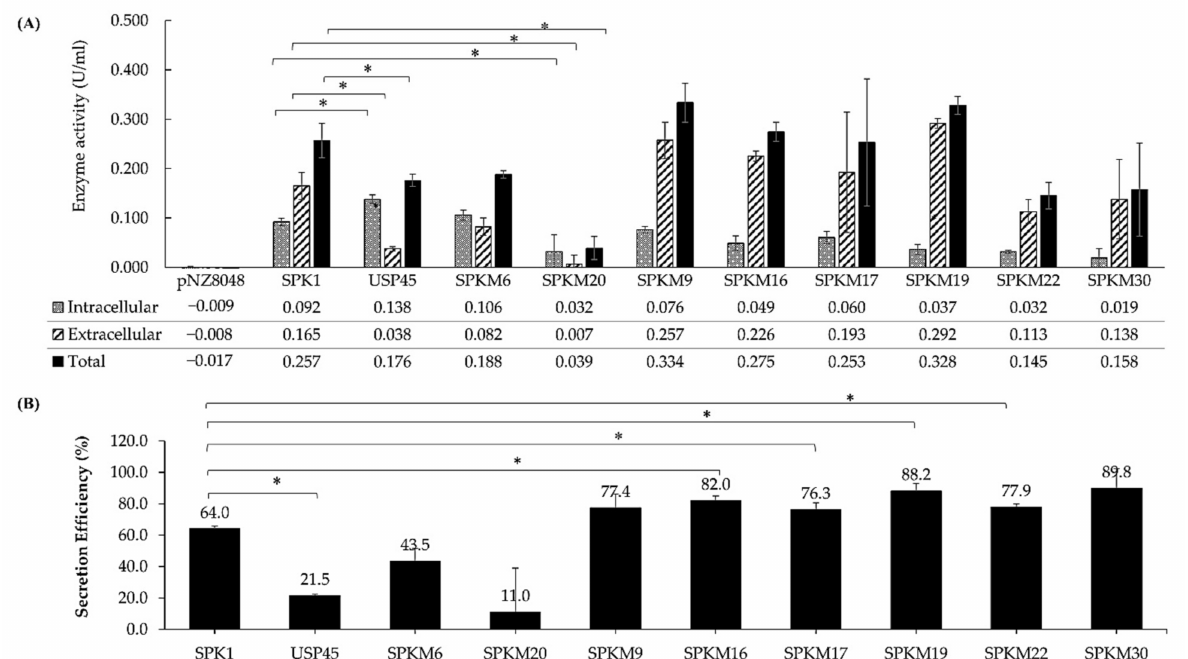
Figure 5. Fluorescence Resonance Energy Transfer (FRET) analysis of ( A ) intracellular, extracellular, and total activity, U/mL, of NUC enzyme by all recombinants. The detection of the intracellular enzyme activity was determined from the concentrated cell lysate, while the extracellular enzyme activity was determined directly from the filtered culture supernatant. The final activity of both fractions was reported after normalization to the dilution factors for accurate comparison. FRET analysis for ( B ) secretion efficiency, which is calculated as the percentage, %, of extracellular activity per total activity of NUC enzyme by all recombinants. The significance difference, p < 0.05, was shown as (*) for all groups when compared to the wild-type